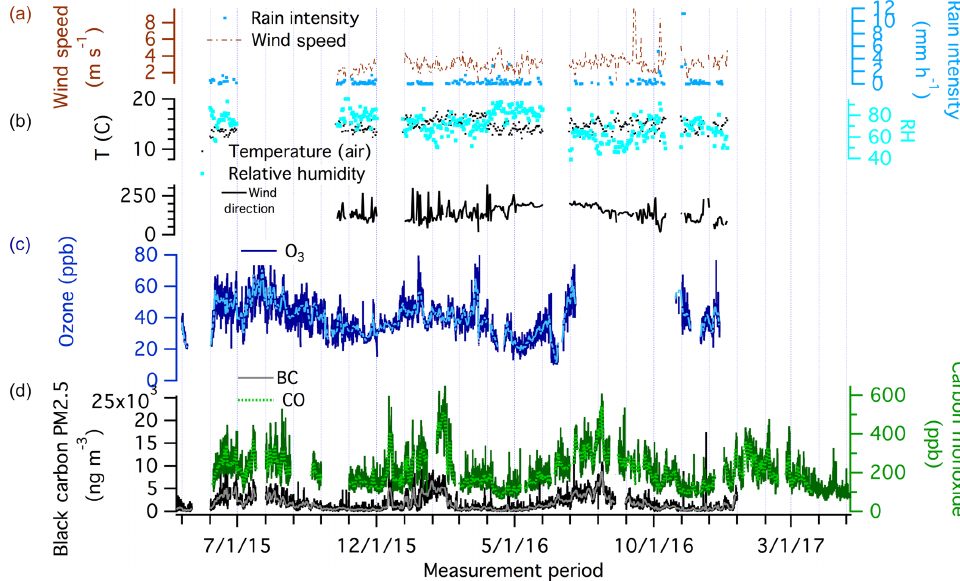
Figure 3. From top to bottom: (a) wind speed (red dotted) and rain intensity (blue dash) daily average values; (b) temperature (black) and relative humidity (light blue) values; (c) ozone (dark blue, light blue) (15min, daily); (d) black carbon (black, grey) and carbon monoxide (dark green, light green) (15min, daily) average concentrations.